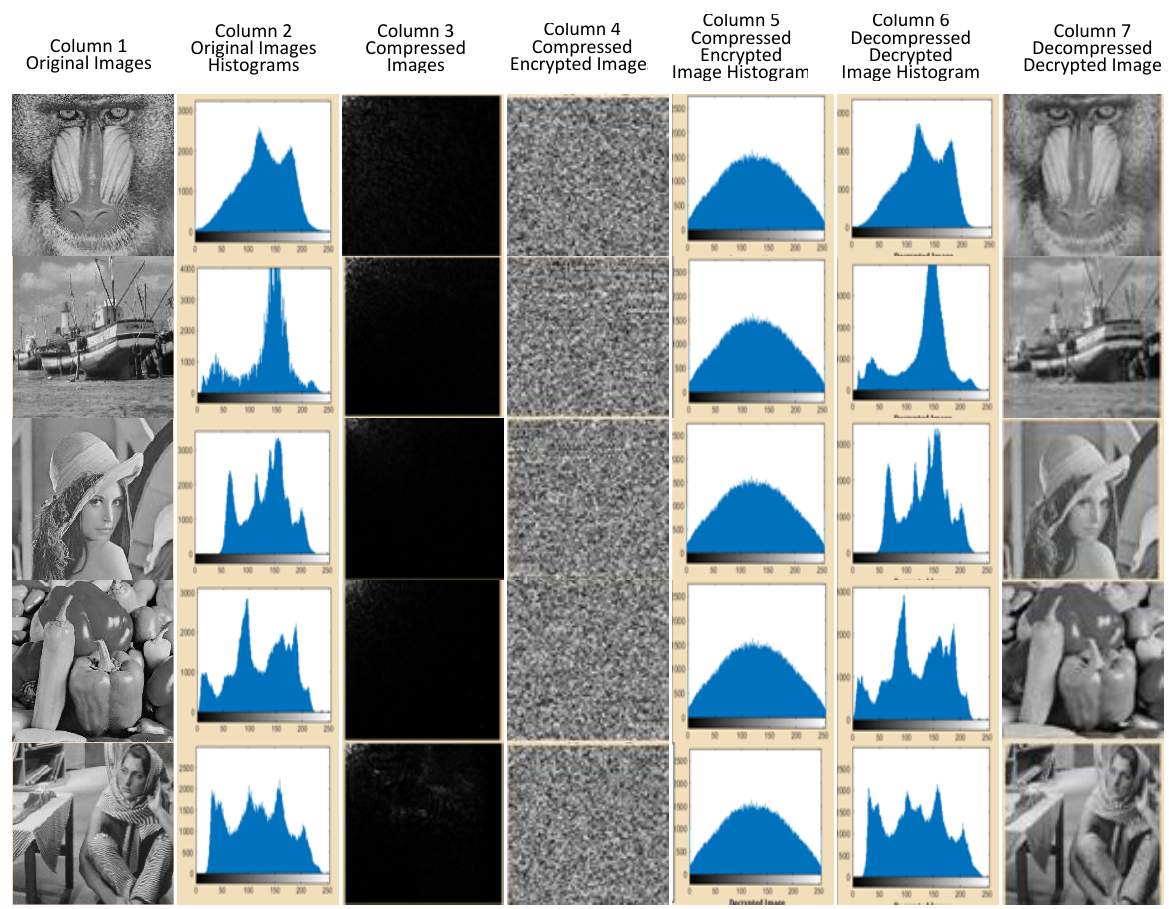
Figure 6 . columns 1-3 are original Images (Courtesy of SIPI image data base), original image histogram, DCT based compressed image respectively, column 4 is AES encrypted image, column 5 is compressed-encrypted image histogram, column 6 is decompressed-decrypted image histogram, and column 7 is decompressed- decrypted